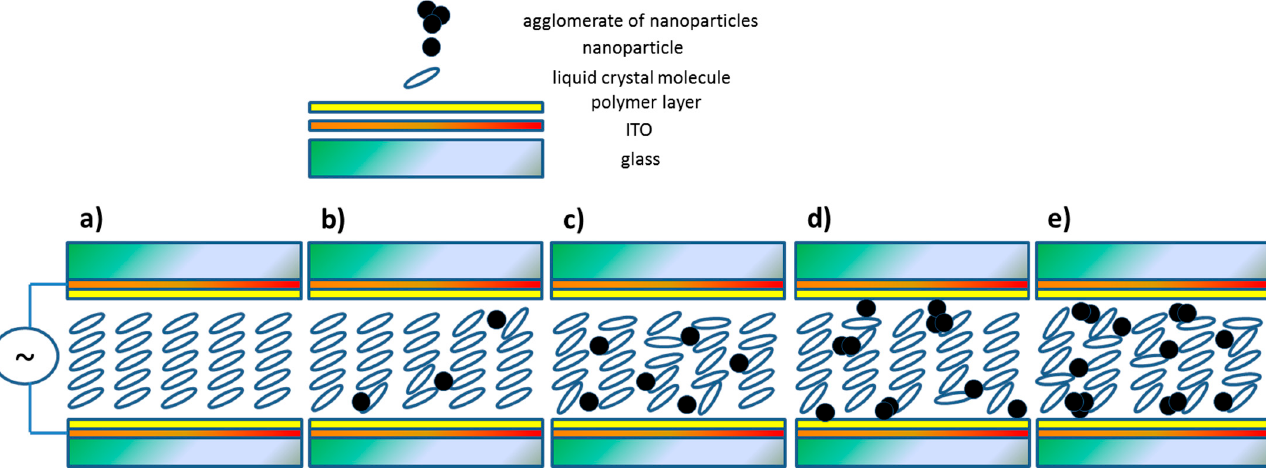
Figure 14. A schematic explanation of the spontaneous polarization behavior in Composites 1–5 with an increase in the concentration of Fe 2 O 3 nanoparticles ( a – e ). Apart from the increase in the amounts of agglomerates in Composite 5 relative to Composite 4, the amount of non-agglomerated nanoparticles increases, which causes a further reduction in spontaneous polarization. The figures are not to scale, in fact the nanoparticles are much larger than the organic molecules. Ions present in the samples, which will reach the properly polarized electrodes under the influence of the AC field, were not taken into account.